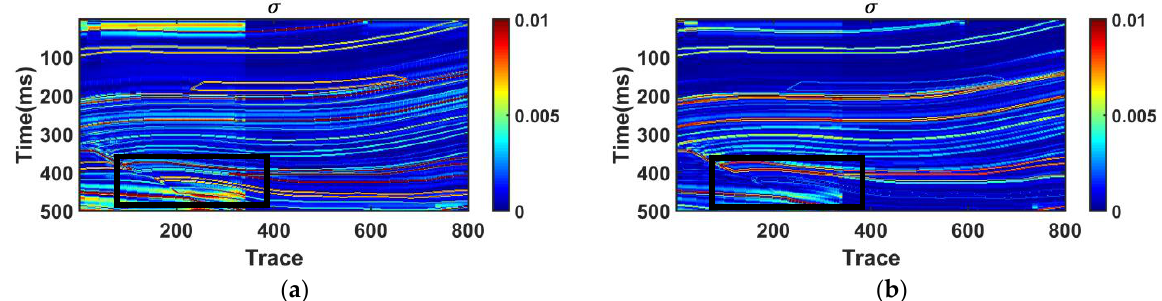
Figure 8. Poisson’s ratio absolute error of inversion based on ( a ) traditional method and ( b ) reweighted Lp method.